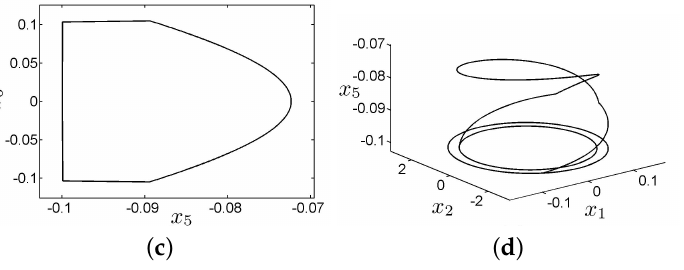
Figure 6. System response in three directions ( ω = 0.11). ( a ) The axial phase diagram. ( b ) The torsional phase diagram. ( c ) The lateral phase diagram. ( d ) Phase diagram in three directions.